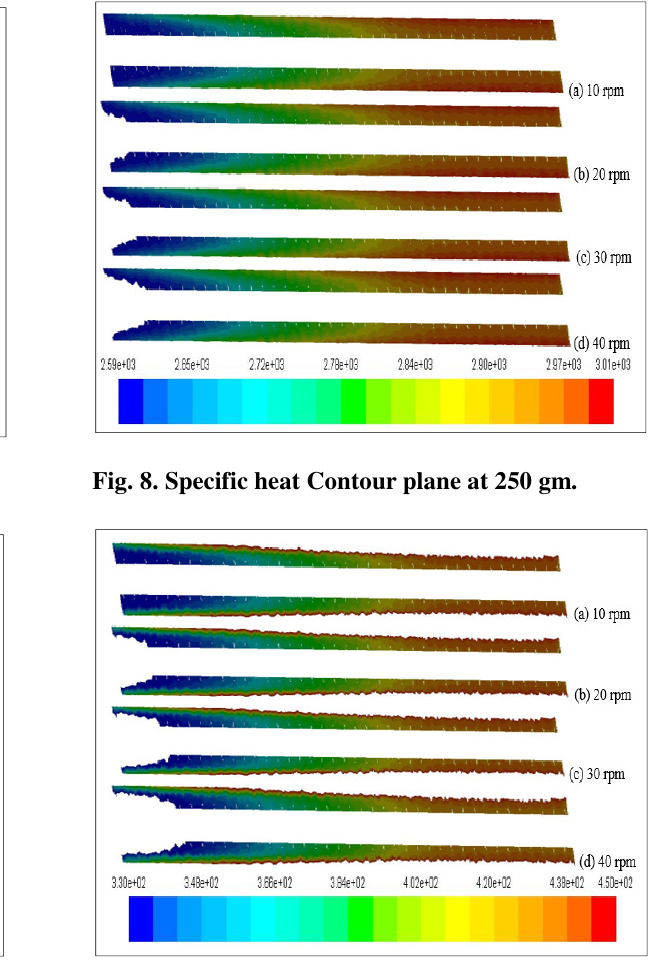
Fig. 6. Viscosity Contour plane at 250 gm.